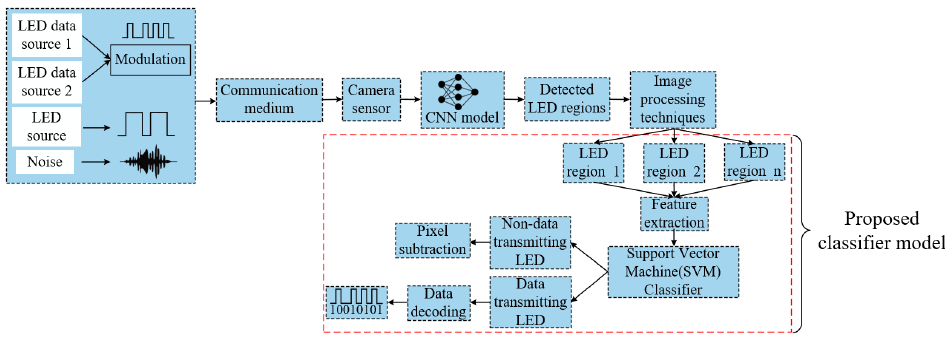
Figure 3. Overall OCC architecture with the proposed classifier